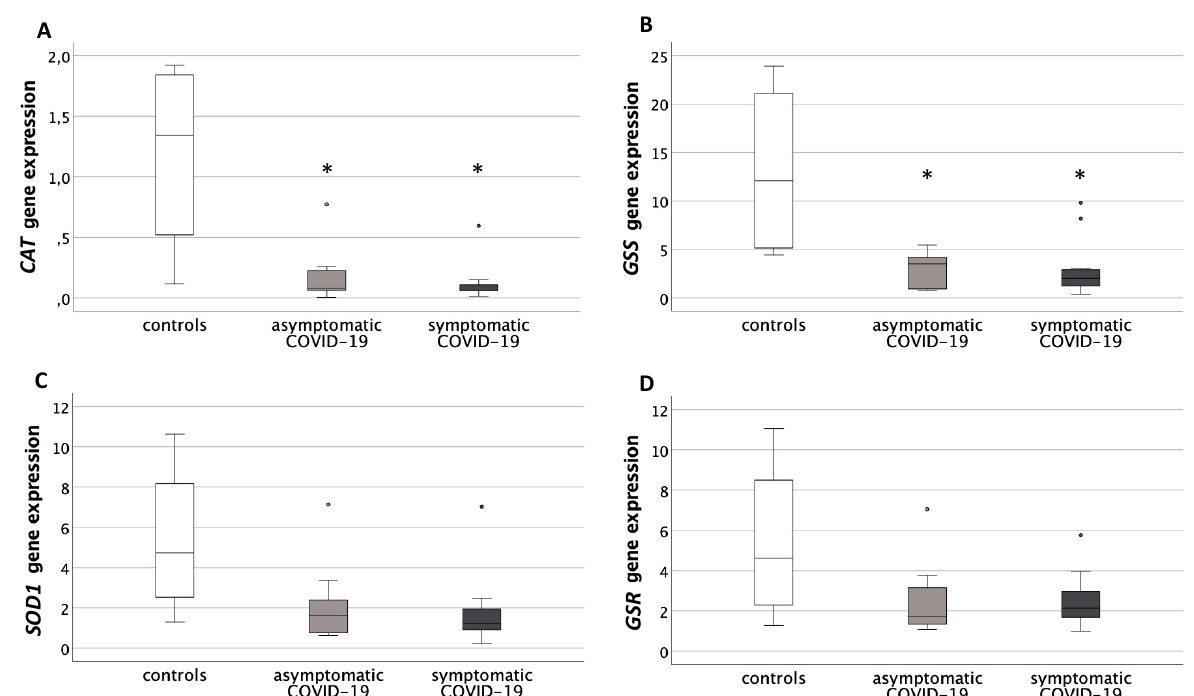
Figure 2. Expression levels of genes related to antioxidant defenses in placentas from healthy control pregnancies and mothers infected with SARS-CoV-2 during the third trimester of pregnancy. ( A ) Placental Catalase ( CAT ) gene expression levels. Data were significantly different among the three groups (Kruskal-Wallis test, p < 0.05). * p < 0.05 vs. controls (Mann-Whitney U test). ( B ) Placental Glutathione SynthetaSe ( GSS ) expression levels. Data were significantly different among the three groups (Kruskal-Wallis test, p < 0.05). * p < 0.05 vs. controls (Mann-Whitney U test). ( C ) Placental SuperOxide Dismutase ( SOD ) gene expression levels. Data were not significantly different among the three groups. ( D ) Placental Glutathione ReductaSe ( GSR ) gene expression levels. Data were not significantly different among the three groups. Round circles are values that differ of more than 2 standard deviations from the median value.